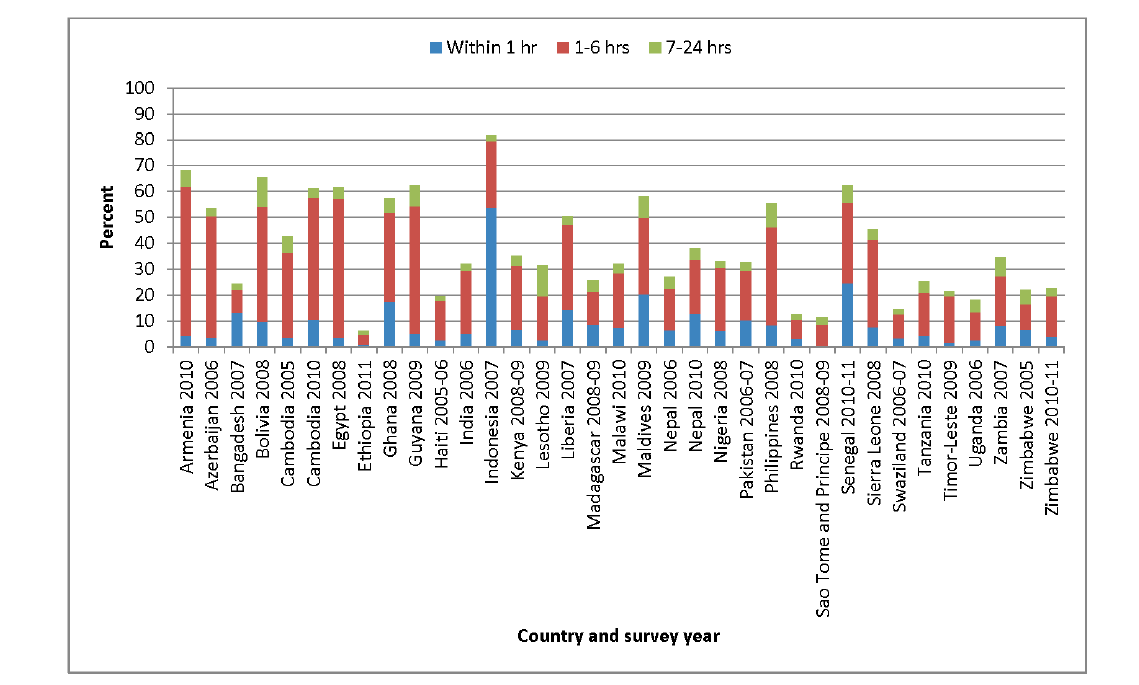
Figure 1. Proportion of women who received postnatal care within two days of delivery by time of first visit, DHS survey data 2005–2011 [ 18 ] .